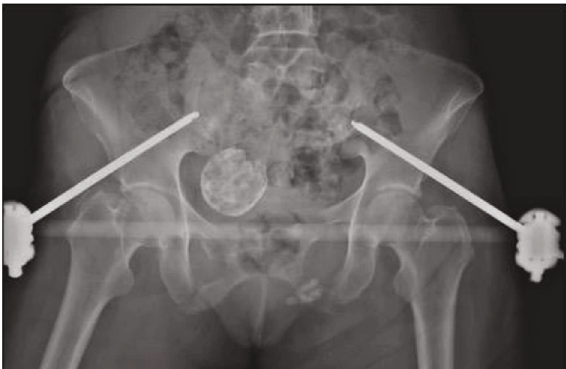
Figure 5: Anteroposterior pelvis radiograph showing the external fi xator in place and the antibiotic beads surrounding the left inferior pubic rami fracture.